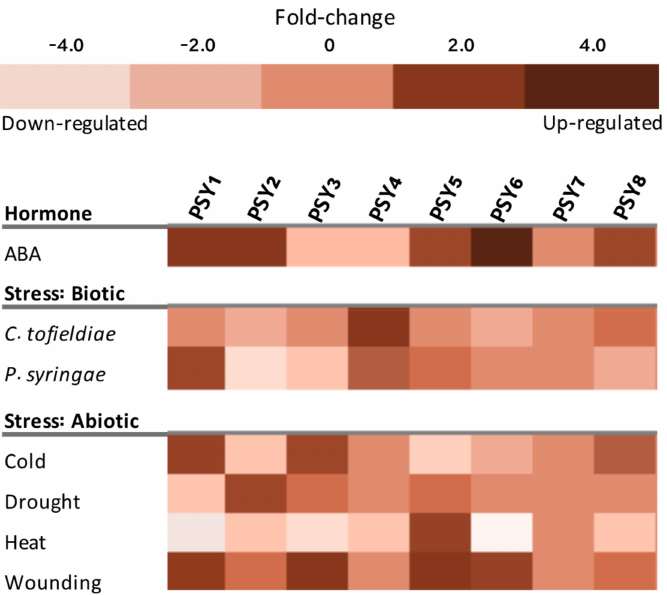
Figure 6. Transcript levels of PSY1-8 affected by selected perturbations based on mRNAseq data from Genevestigator [41]. ABA treatment corresponds to 6 h incubation in 50 µ M ABA solution compared to no treatment. C. tofieldae response was measured 6dpi in roots, P. syringae response was measured 1hpi in rosette leaves and compared to untreated roots and leaves, respectively. Cold stress is 4 ◦ C for 3 h compared to 1 h. Drought stress refers to mild drought stress with soil water content of 1.2 g water g − 1 dry soil for 6d compared to no stress. Heat stress refers to 3-week-old rosette samples grown at 21 ◦ C, 16 h light regime, exposed to 37 ◦ C for 6 h compared to rosette samples receiving no heat stress. Wounding refers to wounded leaves measured 3 h after wounding compared to 1 h. Effect of selected treatments is illustrated as